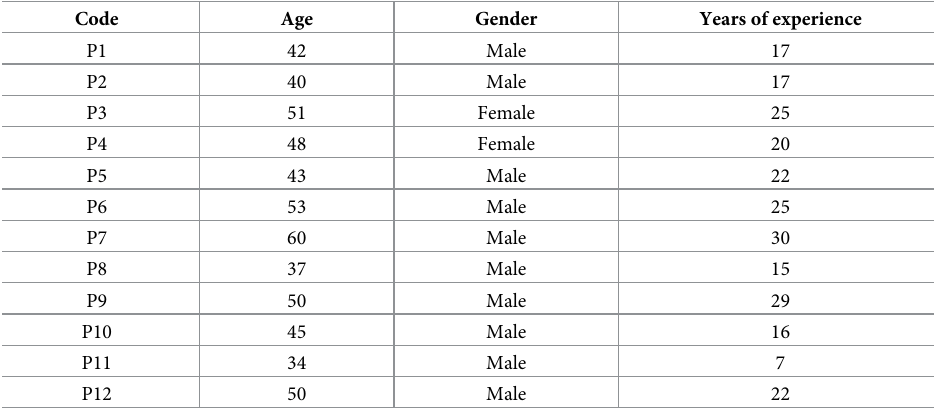
Table 3. Demographics of the participating physicians in